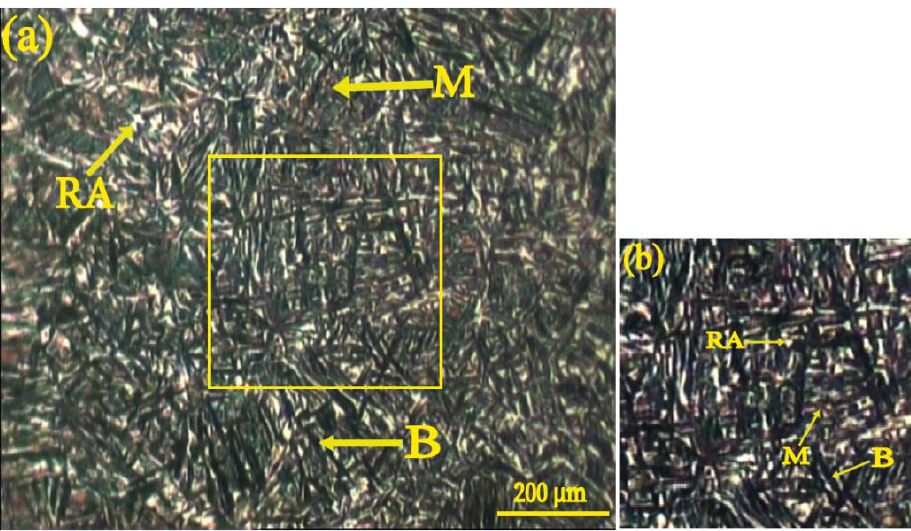
Figure 6. ( a ) Quadruple-step etching technique (2% nital + 10% ammonium persulfate + Marble’s reagent + Klemm’s Ι solution at 40 °C). ( b ) Enlarged image view of the square shown in ( a ). The abbreviations B, M and RA represent bainite, martensite and retained austenite phase constituents, respectively.